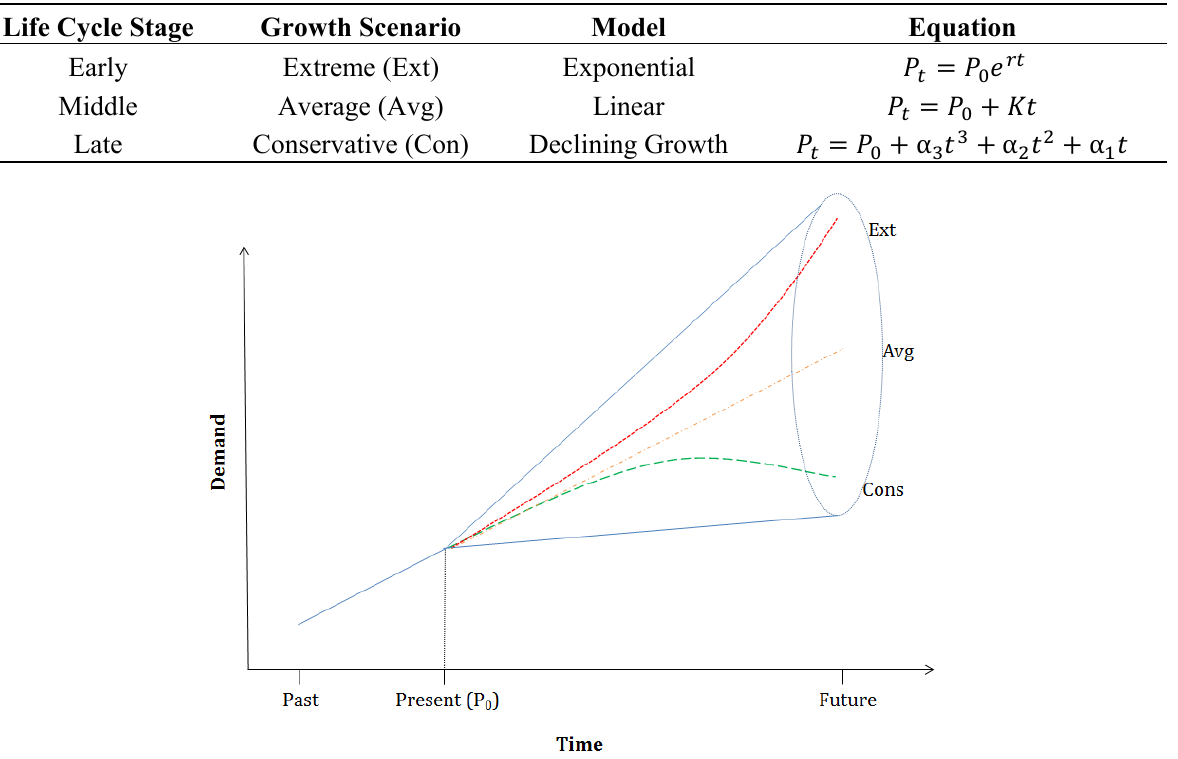
Table 1. Generic future demand models according to life cycle stage.